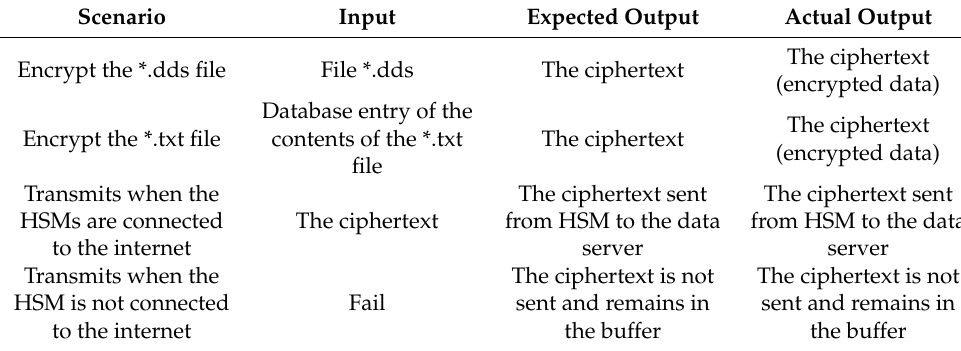
Table 9. Encryption and transmission testing.